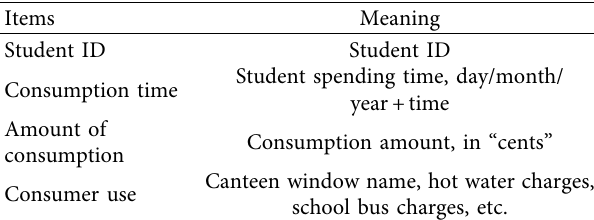
Table 4: Campus consumption card records.